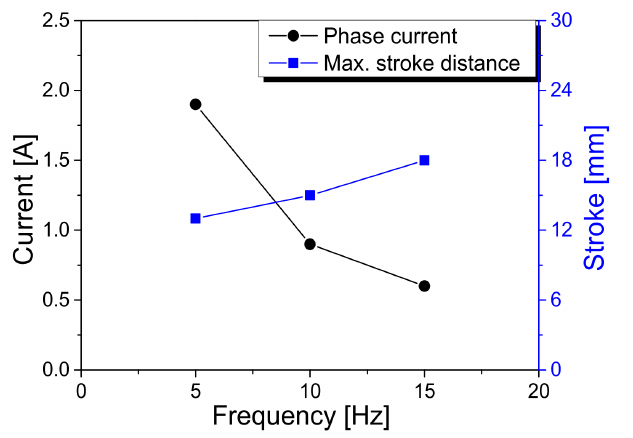
Figure 8. Test results of the prototype of model 2 in low frequency